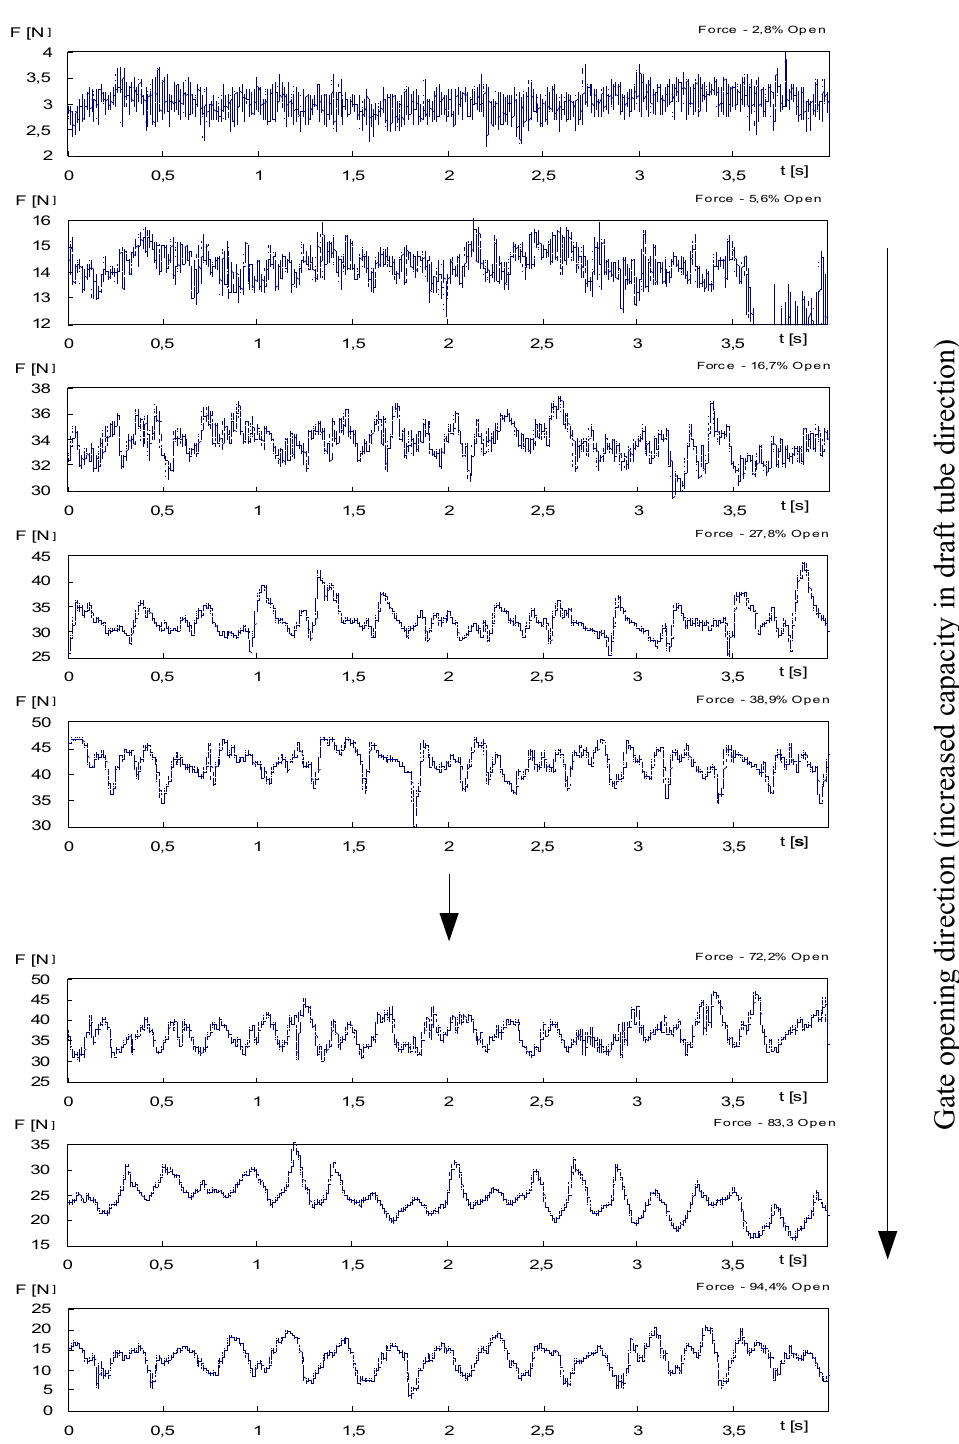
Fig. 5. Time history records of acting force measured at the gate suspension in vertical direction at different gate openings, from 2.8% up to